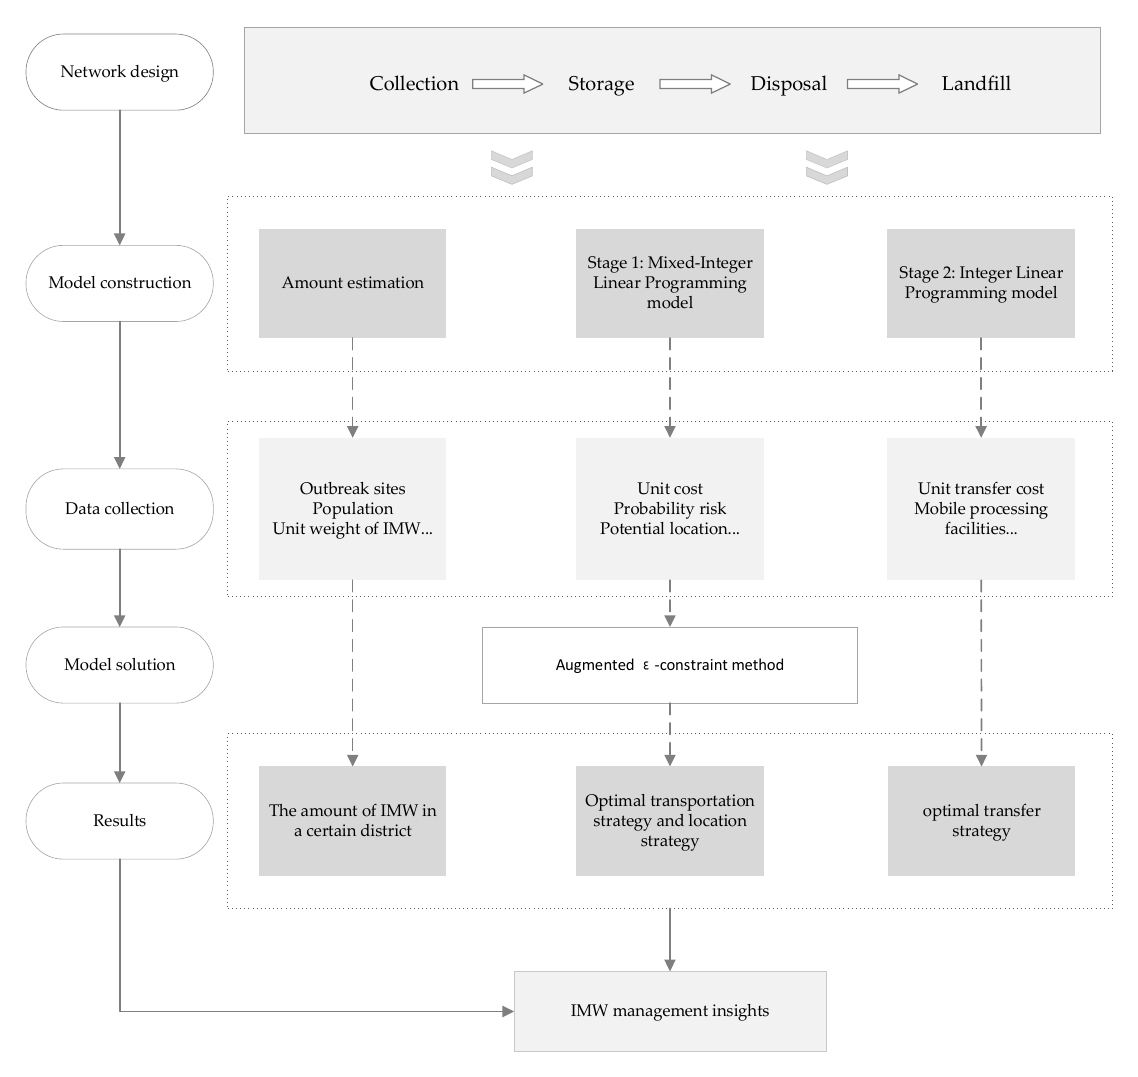
Figure 1. Flow diagram to show the method in this study.